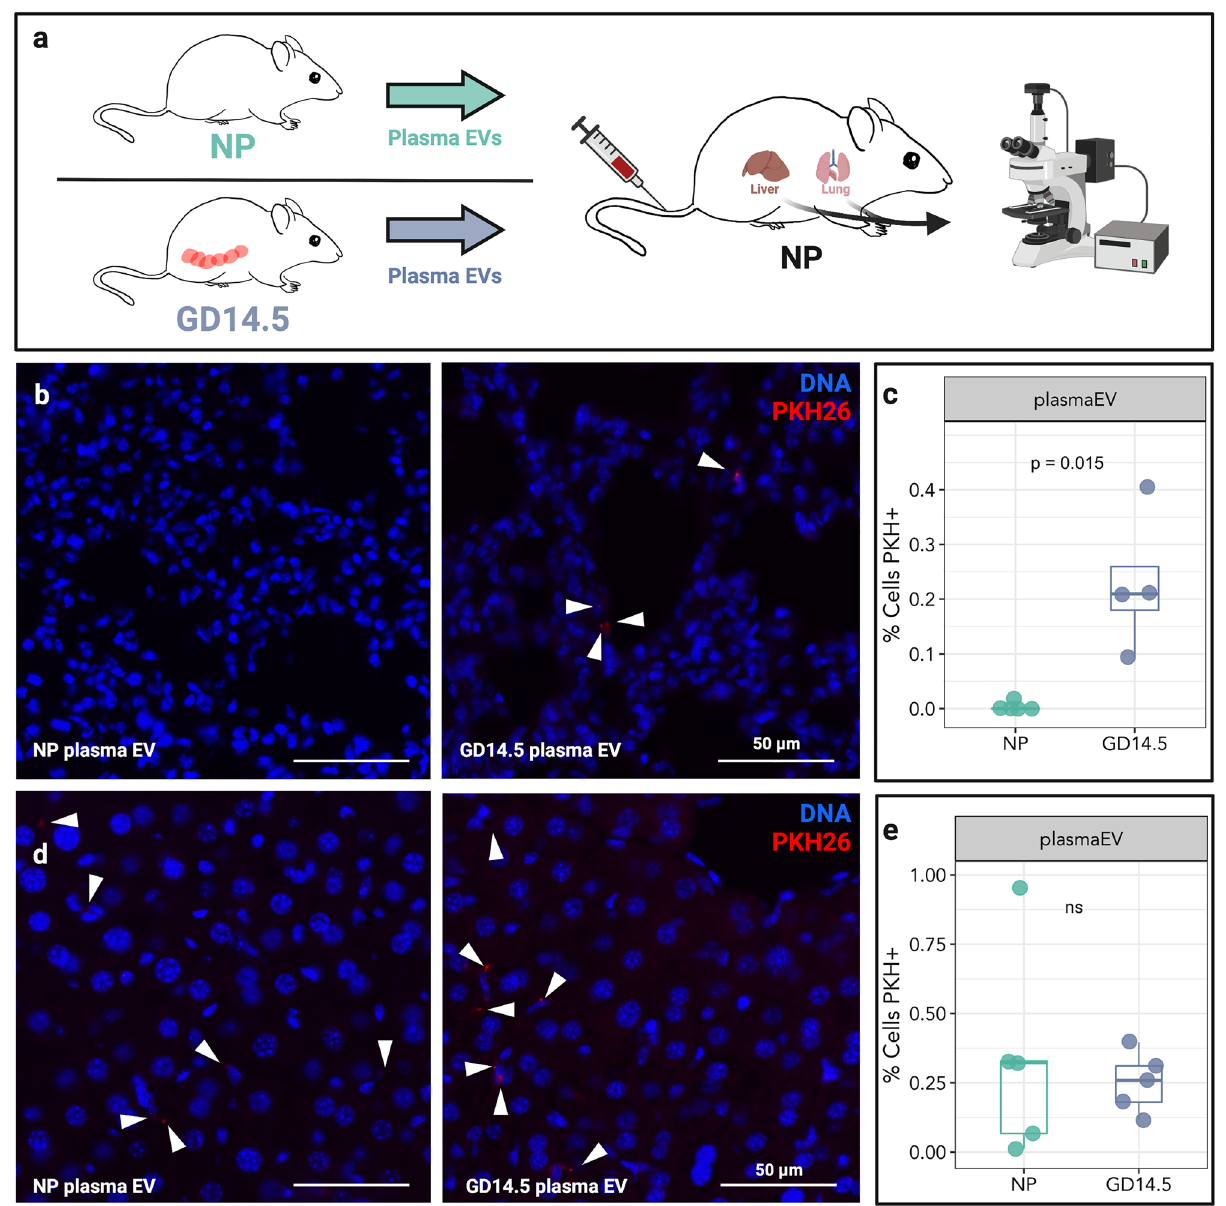
Figure 1. Pregnant plasma EVs traffic to murine lungs and liver in vivo. ( a ) Plasma EVs (2.5 × 10 10 ) isolated from the plasma of nonpregnant (NP) or GD14.5 pregnant mice were labeled with PKH26 and administered i.v. into NP mice. Mice were sacrificed after 30 min, and lung and liver were analyzed by epifluorescence microscopy. ( b ) Fluorescence microscopy of lung from a mouse treated with plasma EVs from nonpregnant (NP, left; n = 5) or GD14.5 pregnant (right; n = 4) mice (Arrowheads, EVs). Images are representative of five random fields examined in each animal. ( c ) Quantification of plasma EVs as evidenced by presence of red fluorescence in recipient lung. Dots represent biological replicates, Wilcoxon test. ( d ) Fluorescence microscopy of liver from a mouse treated with plasma EVs from nonpregnant (NP, left; n = 5) or GD14.5 pregnant (right, n = 5) mice EVs (Arrowheads, plasma EVs). Images are representative of five random fields examined in each animal. ( e ) Quantification of plasma EVs as evidenced by presence of red fluorescence in recipient liver. Dots represent biological replicates, Wilcoxon